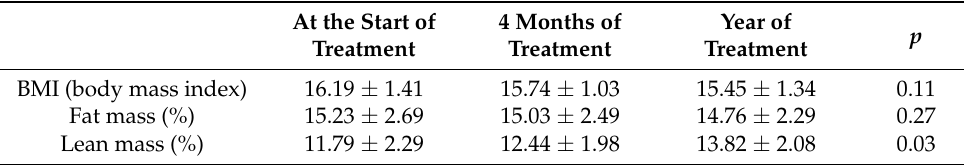
Table 6. Anthropometric assessment at the start, after four months and after one year. At the Start of 4 Months Treatment